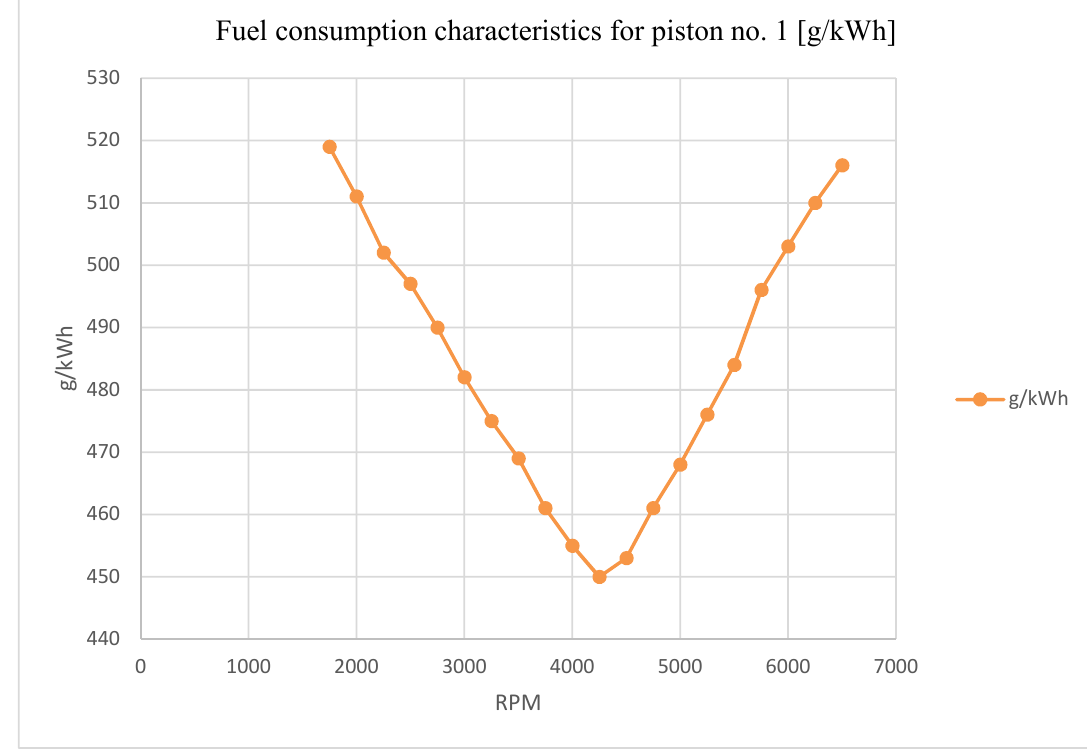
Figure 20. Fuel consumption characteristics for piston no. 1.